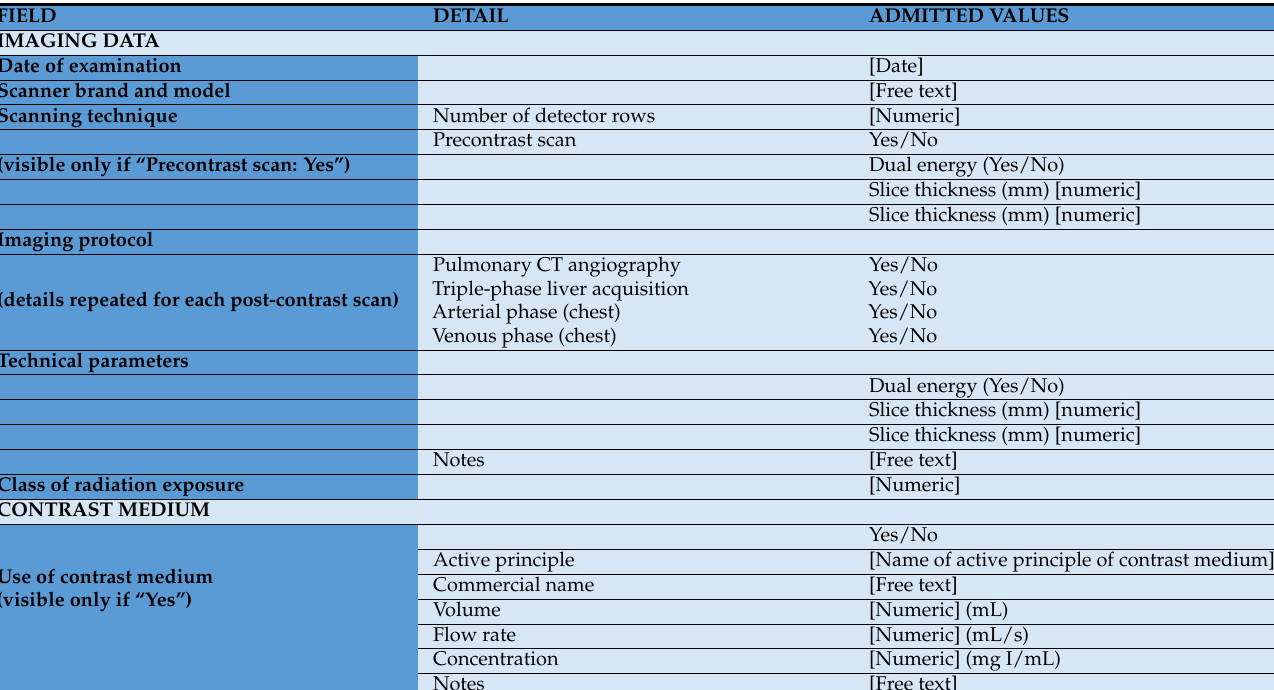
Table A4. Imaging protocol.